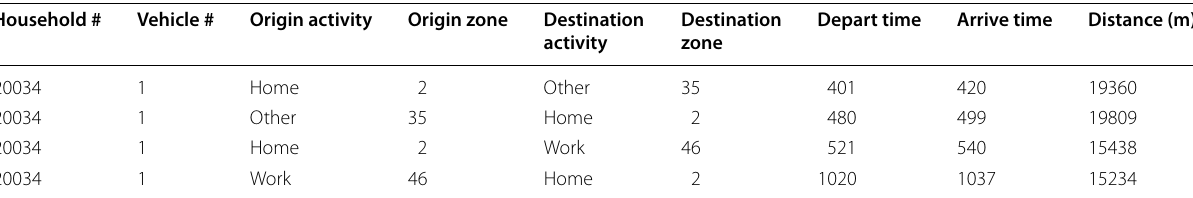
Table 1 Sample vehicle schedule Household